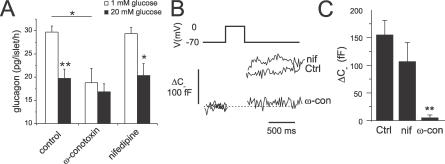
Glucagon Secretion Is Regulated by N-Type Ca2+ Channels(A) Glucagon release measured at 1 (open bars) and 20 mM glucose (filled bars) under control conditions and in the presence of 100 nM ω-conotoxin (middle) or 20 μM nifedipine (right).(B) Exocytosis was elicited by 500-ms depolarisations from −70 to 0 mV under control conditions (Ctrl) and in the presence of either nifedipine (50 μM; nif) or ω-conotoxin (1 μM; ω-con).(C) Summary of the exocytotic response under control conditions and in the presence of nifedipine and ω-conotoxin.*, p < 0.05; **, p < 0.01, compared with 1 mM glucose and the control capacitance response, unless indicated otherwise.